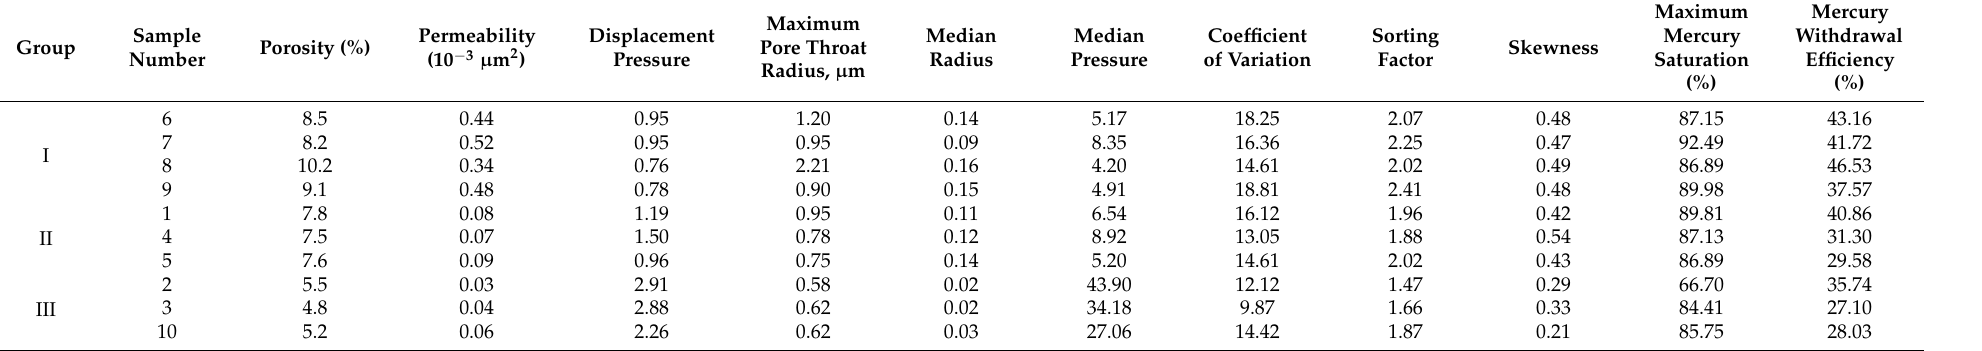
Table 2. Classification of Representative Samples of Chang 8 Reservoir in the Study